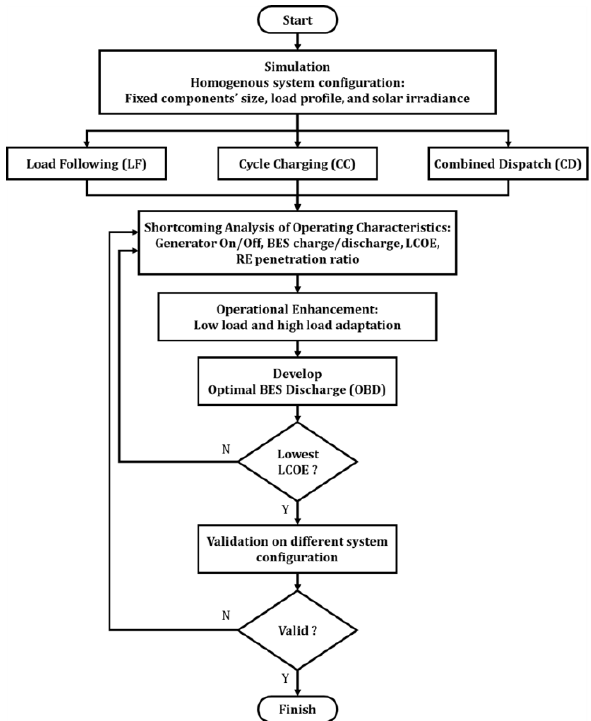
Figure 4. The research framework of the proposed control strategies.